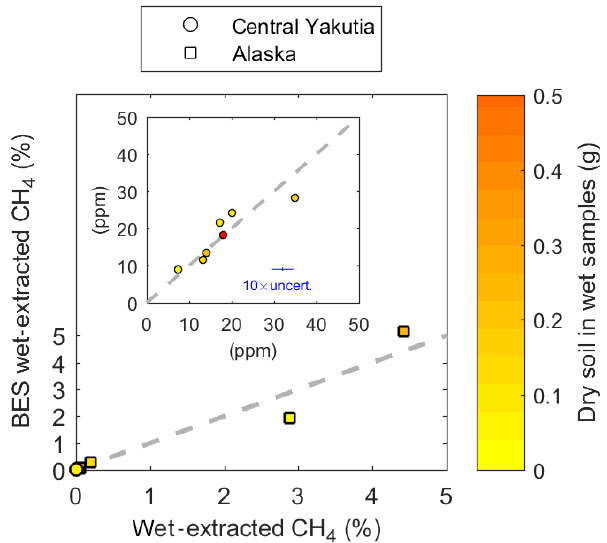
Figure A3. Comparison between control and BES-treated wet ex- traction results for CH 4 . The sampling area is indicated by different symbols. The colour of each data point indicates the dry soil weight in the subsamples used in control wet extraction. The grey dashed lines are 1 : 1 reference lines. The blue error bar indicates the 1 σ uncertainty of mixing ratios magnified by 10 ×